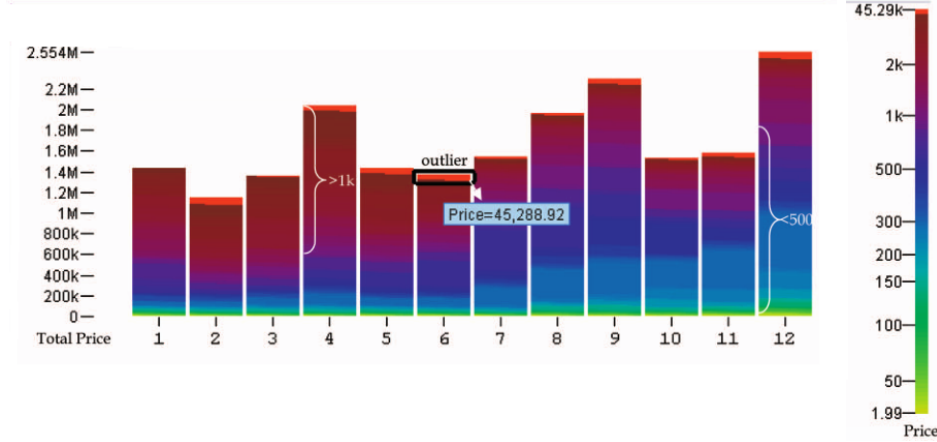
Figure 9. The Value-Cell bar chart. Each bar represents a month worth of sales. Within the bar, tiered sales values for each month are shown. The red tips of some bars represent outlying large sales during that time period. The colour legend shows the value of the transactions. The tiers blend together to create a gradation effect. Image courtesy of Keim et al.